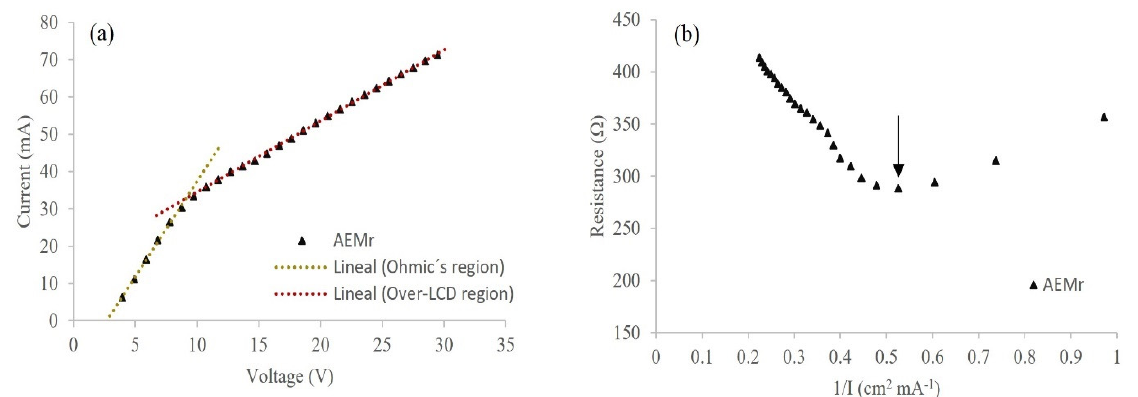
Figure 4. ( a ) Current-voltage and ( b ) Cowan-Brown method for the determination of LCD with recycled anion-exchange membranes (rAEMs) (flow rate of 20 mL min − 1 and 4 cell pairs). Based on the intersection points in Figure 4a, the LCD was identified as equal to 1.90